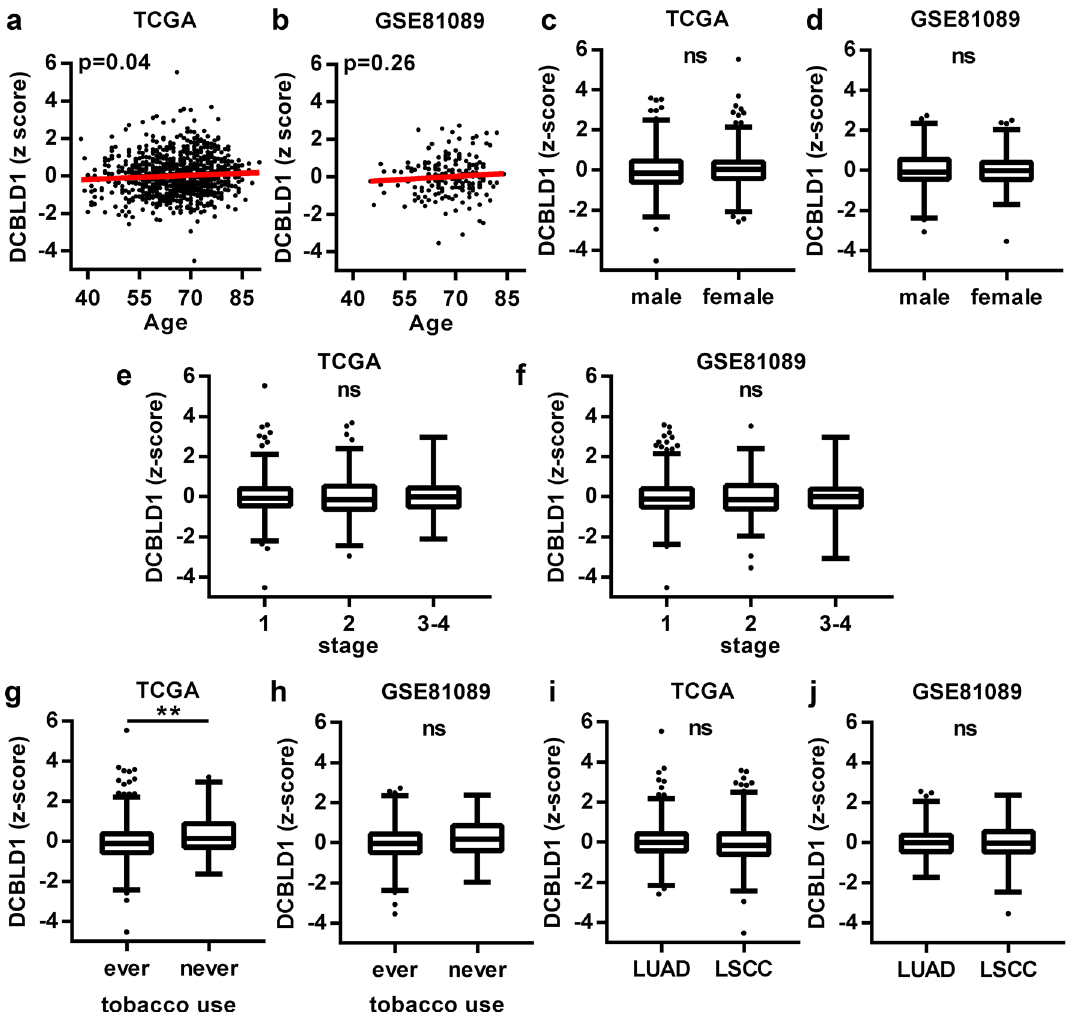
Figure 1. DCBLD1 in the TCGA and GSE81089 cohorts of non-small cell lung carcinoma. Comparison of DCBLD1 gene expression for age ( A , B ), sex ( C , D ), stage ( E , F ), tobacco use ( G , H ) and histology ( I , J